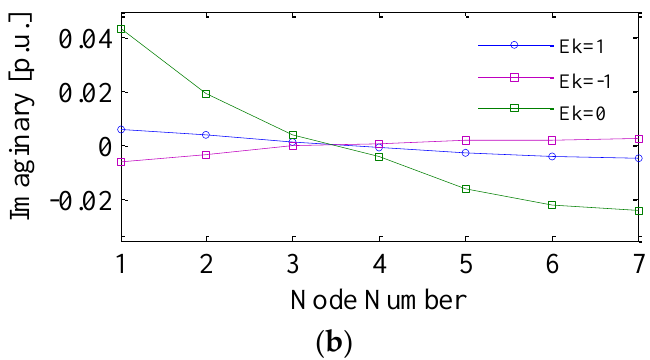
Figure 4. Bus voltage phasors with ( a ) real part and ( b ) imaginary part using conventional adaptive estimator without tolerant estimation.